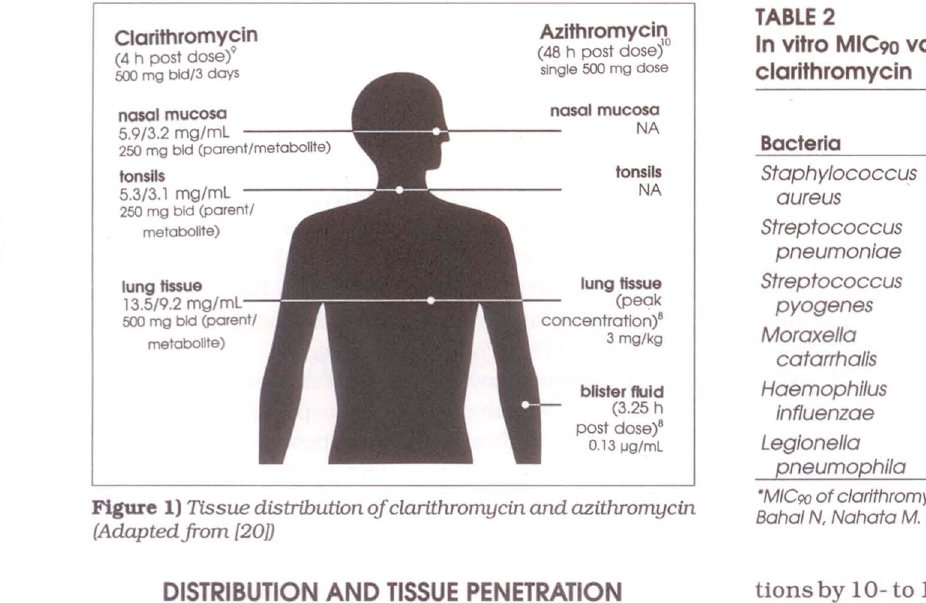
Figure 1) Tissue distribution of clarithromycin and azithromycin (Adapted .from [20]) DISTRIBUTION AND TISSUE PENETRATION